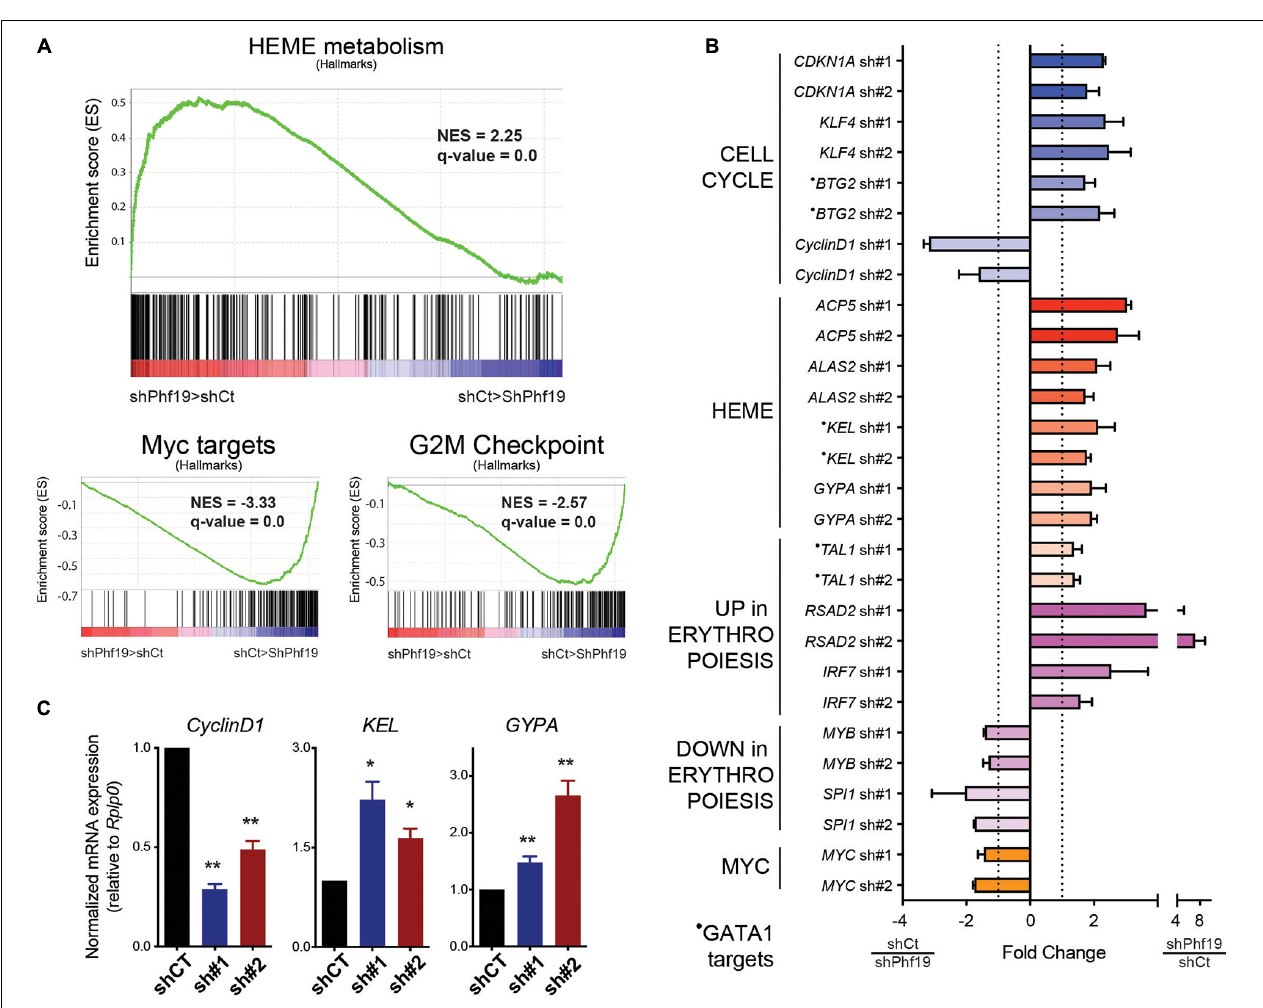
FIGURE 2 | (A) Gene set enrichment analysis (GSEA) showing positive enrichment in the PHF19 -depleted transcriptome for Heme metabolism and negative enrichment for Myc targets and G2/M checkpoint (hallmarks). (B) Normalized fold change expression (using reads per kilobase of transcript per million mapped reads, RPKMs) for the two short hairpin RNAs (shRNAs) against PHF19 (sh#1 and sh#2) with respect to cells infected with shCT (empty shRNA) in relevant genes from two independent RNA-seq experiments. Mean + SEM. (C) Expression of cyclin D1 ( CCND1 ), KEL , and GYPA in sh#1 and sh#2 K562 cells, measured by qPCR relative to the housekeeping gene RPLP0 and normalized by shCT expression. Mean ( n > 3 in all cases) + SEM. ∗ p < 0 . 05 ; ∗∗ p < 0 . 01